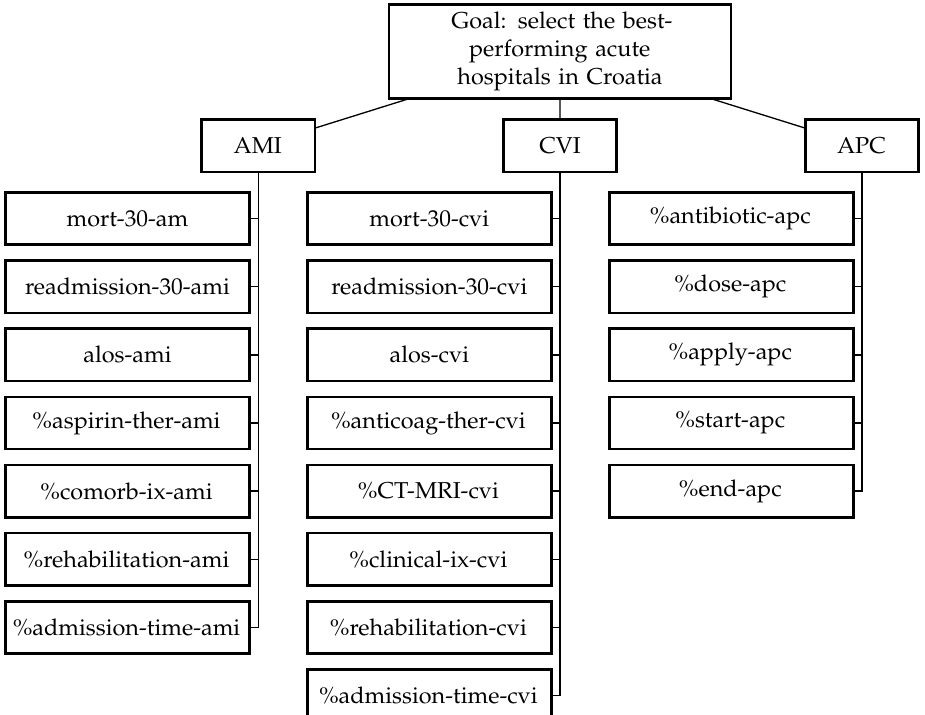
Figure 4. A hierarchical tree for selecting the best-performing acute hospitals in Croatia AMI = acute myocardial infarction; CVI = cerebrovascular insult; APC = antimicrobial prophylaxis in colorectal surgery, criteria below the entities are labeled using abbreviations from Table